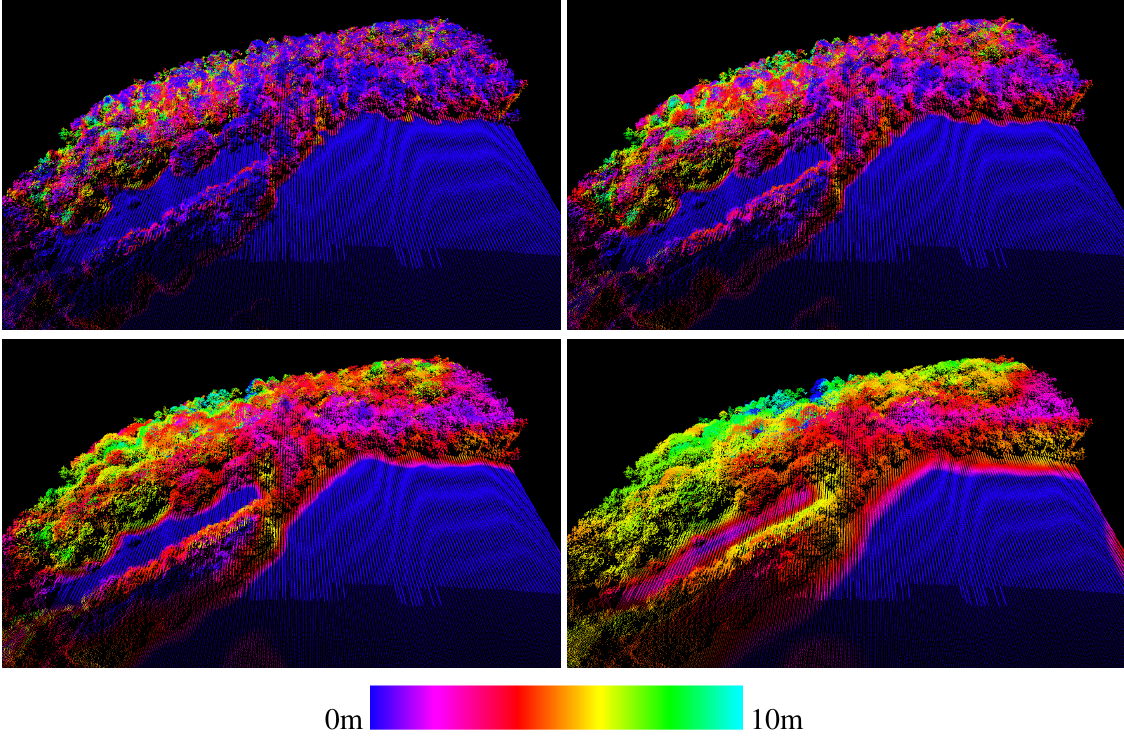
Figure 7. Feature standard deviation of elevation in the neighborhood for a 2D neighborhood with radius of 2 m, 4 m, 8 m and 16 m in a 3D view. Differing data density due to strip overlaps is visible in the foreground, but without influence on the computed feature